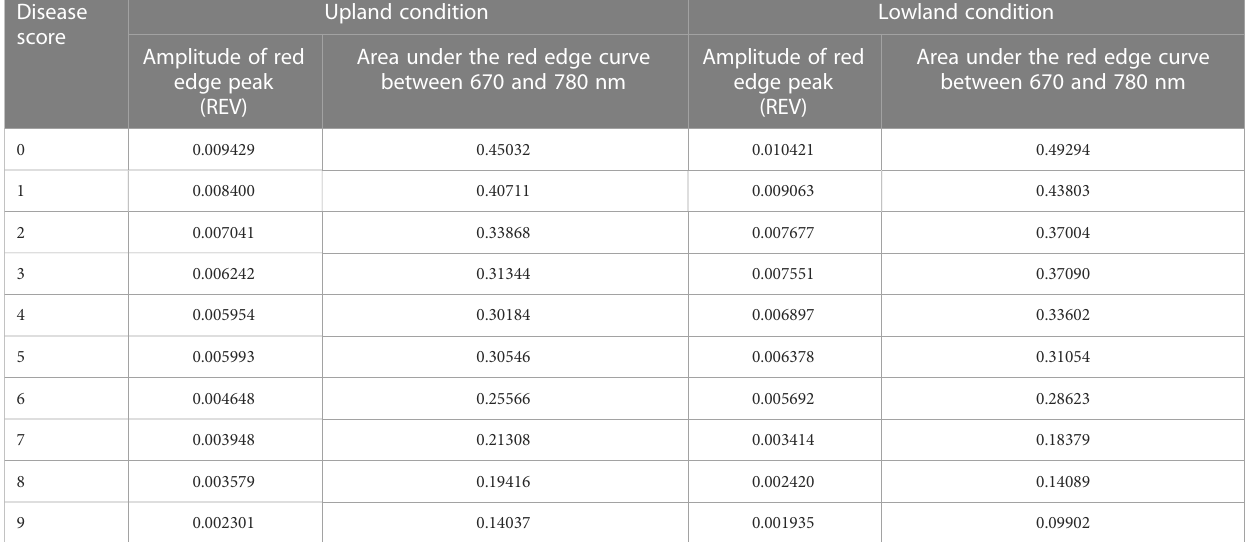
TABLE 5 Effect of blast severity on red edge characteristics.